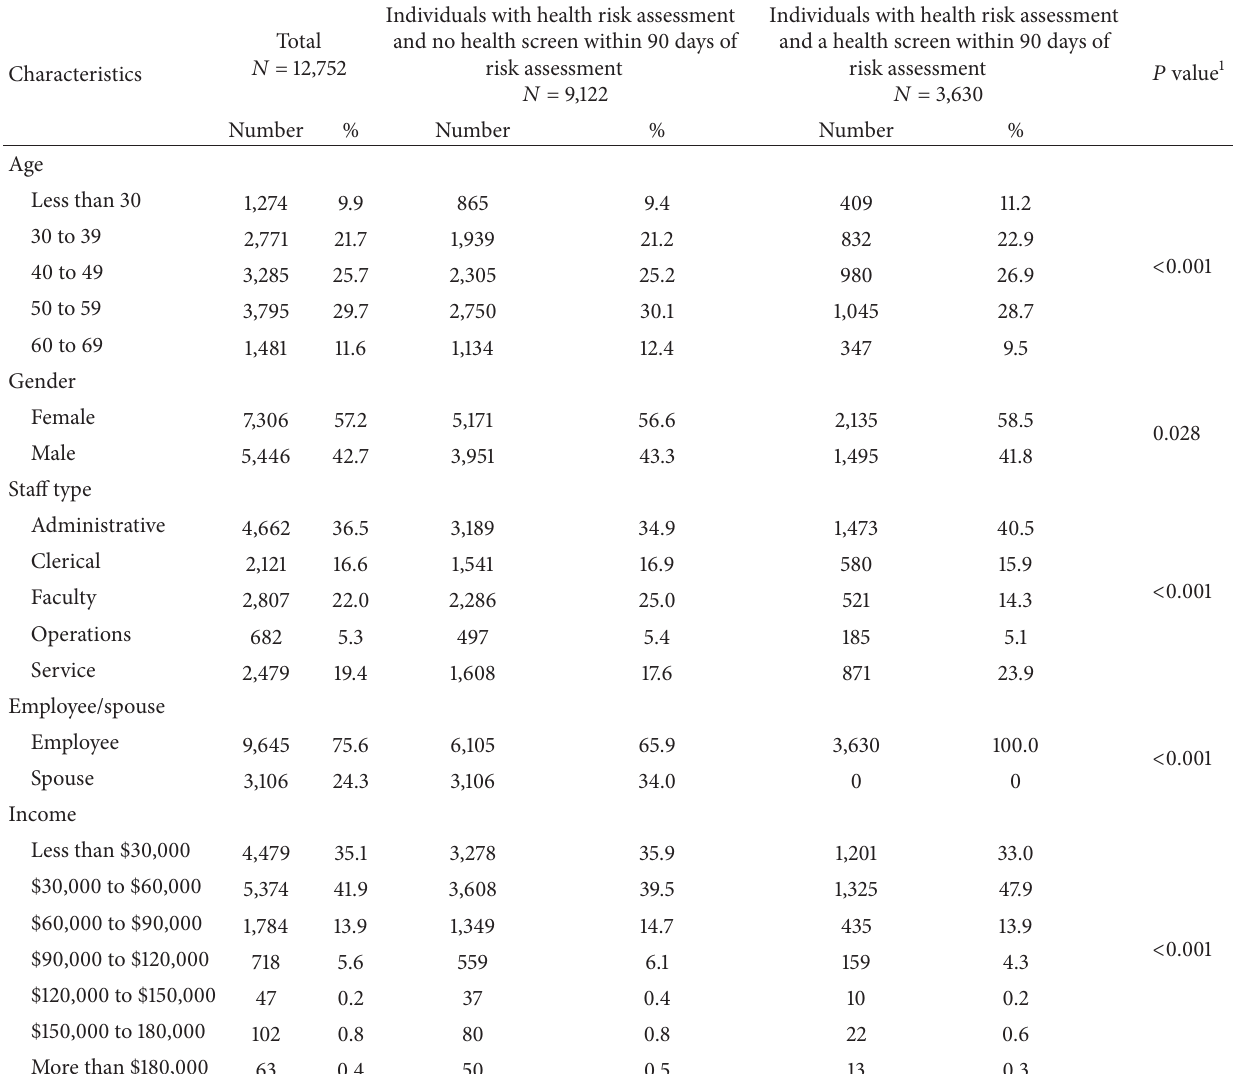
Table 1: Sample Distribution by Demographic Characteristics.